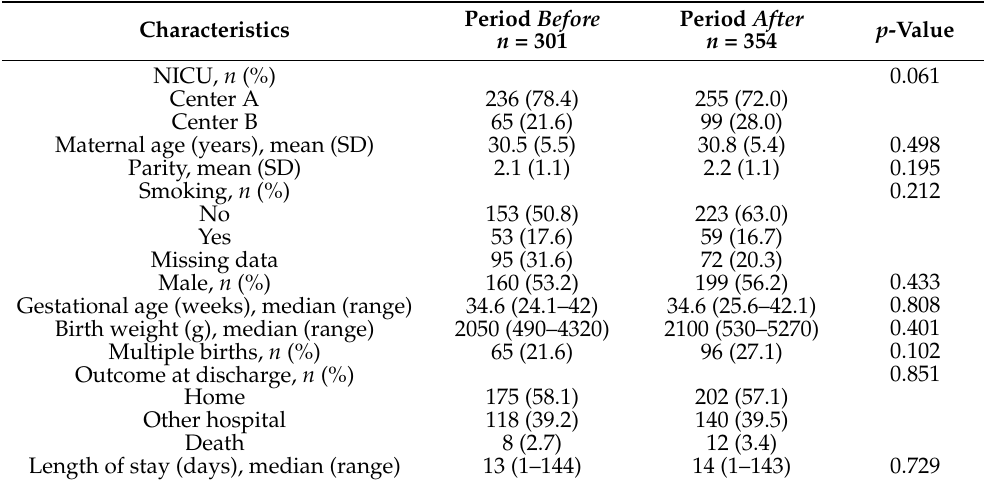
Figure 1. Study flow chart. Table 1. Perinatal characteristics of the population before and after the implementation of the Doal